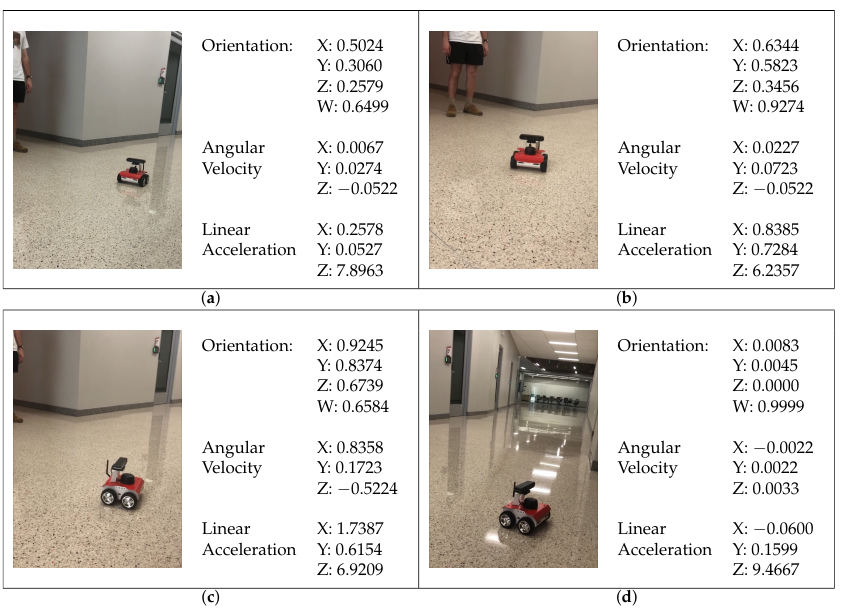
Figure 14. ( a ) Initial rover position status metrics from the website alongside real world reference. ( b ) Second rover position. ( c ) Third rover position. ( d ) Final rover position. Notice the orientation was reset to near zero; this indicates that the rover has reached the goal.